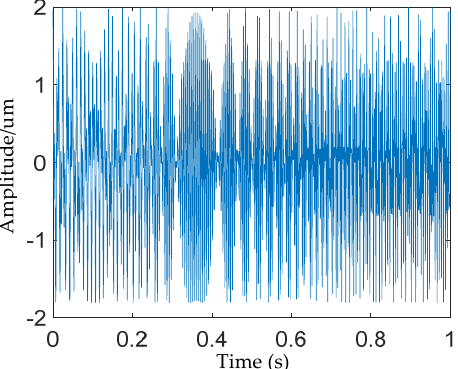
Figure 10. Time domain waveform of simulation signal.